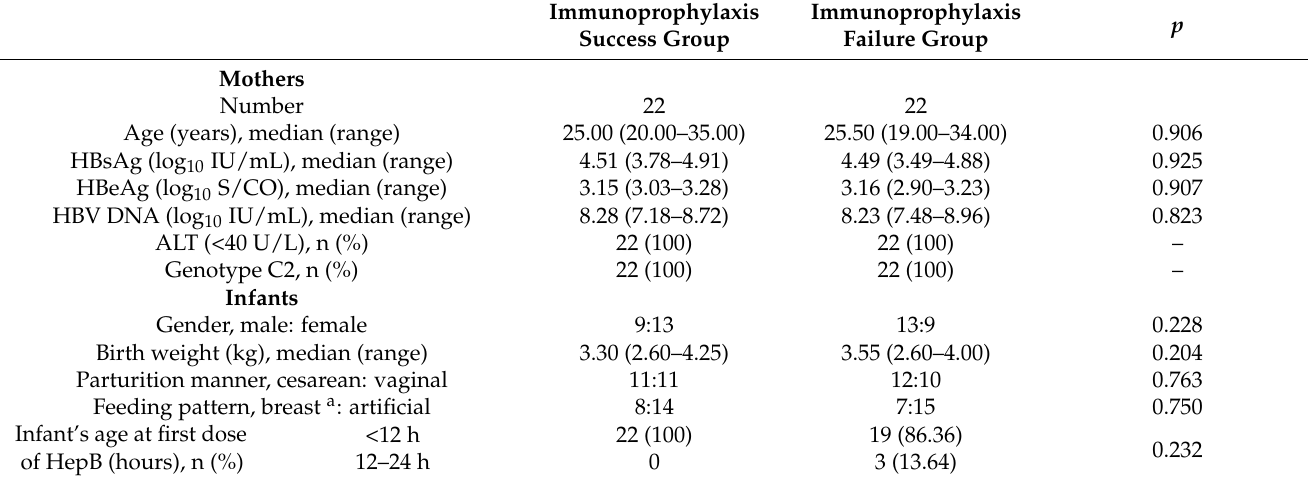
Table 1. The baseline characteristics between the immunoprophylaxis failure and success group.